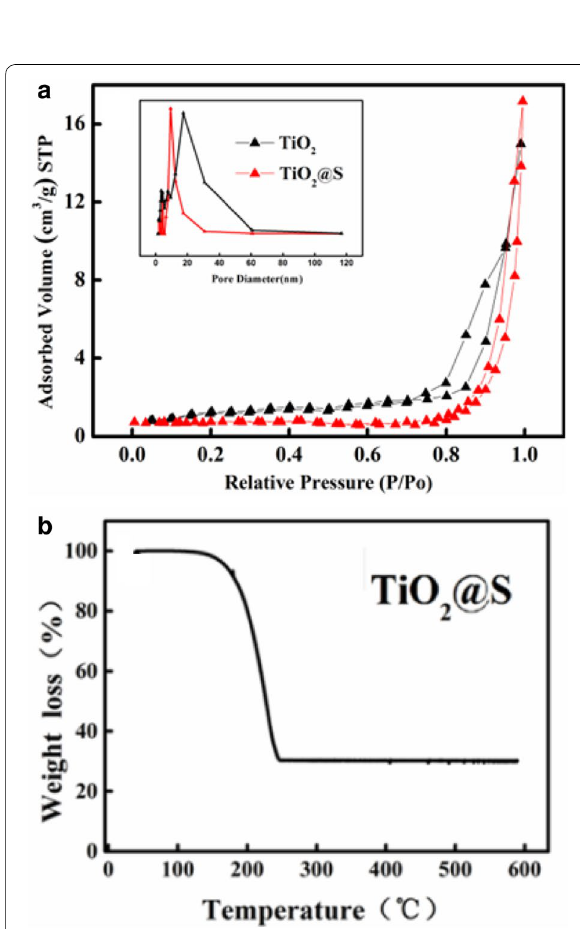
Figure 5 a Nitrogen adsorption-desorption isotherms and corresponding pore size (inset) distribution of TiO 2 , TiO 2 /S composite, b Thermogravimetric plot of TiO 2 /S composite in Ar atmosphere heating from room temperature to 600 °C